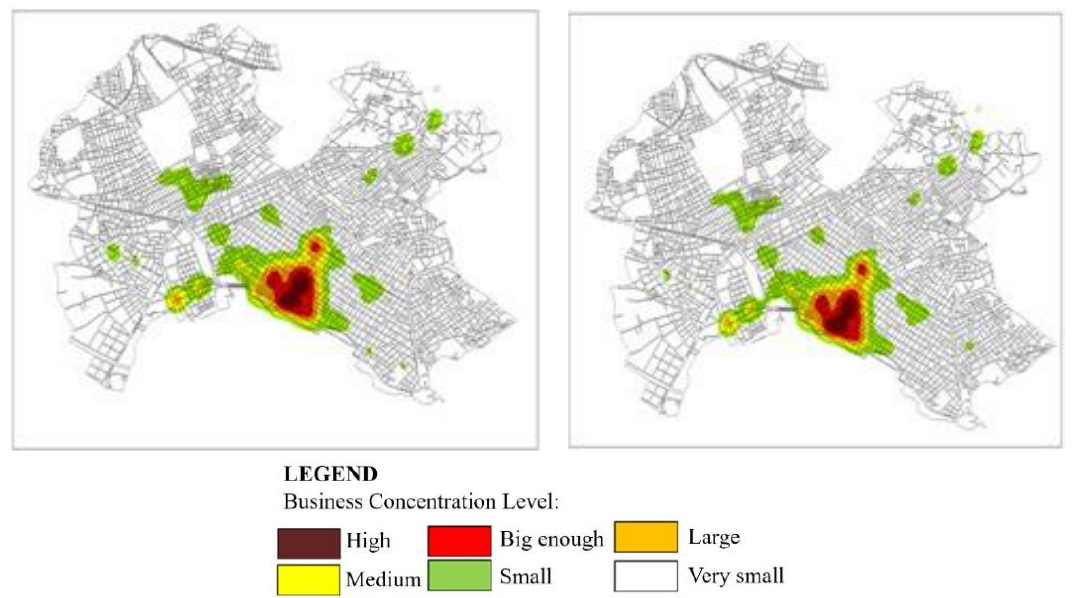
Figure 4. Kernel density for the years 2008–2018 for all companies, Source: Chamber of Magnesia, Own processing.